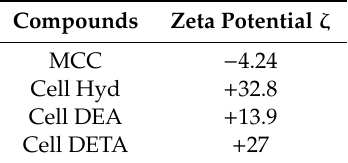
Table 2. Characterization of cellulose amine derivatives zeta potential